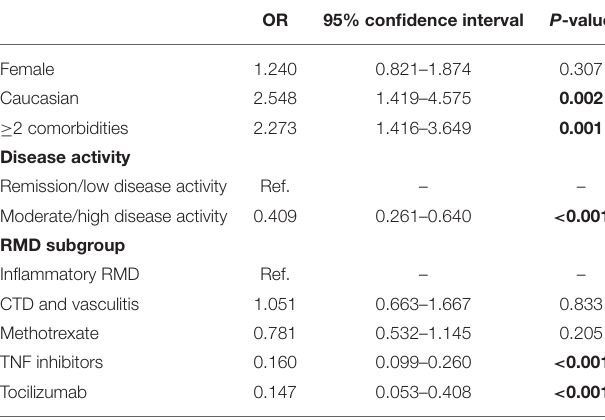
TABLE 3 | Characterization of COVID-19 in patients with